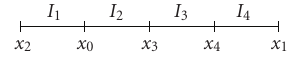
Figure 2.1. Partition of the interval corresponding to the kneading sequence